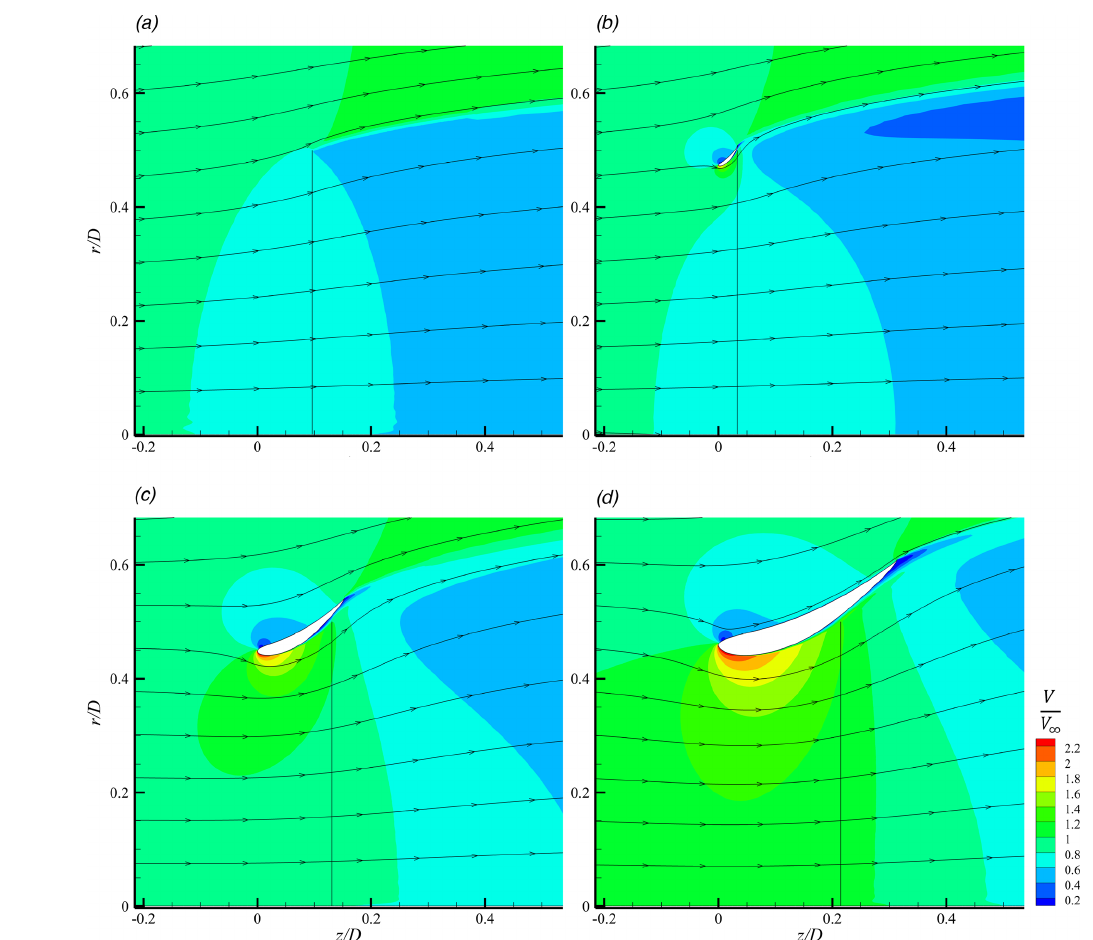
Figure 7. The streamlines and contours of nondimensional velocity magnitude V/V ∞ of (a) the actuator disc, shown by the radial black line, at C T = 8 / 9, and the designs for optimal C P , total at Re c = 3 × 10 5 at (b) c/D = 0 . 05, (c) c/D = 0 . 18, and (d) c/D = 0 . 35.